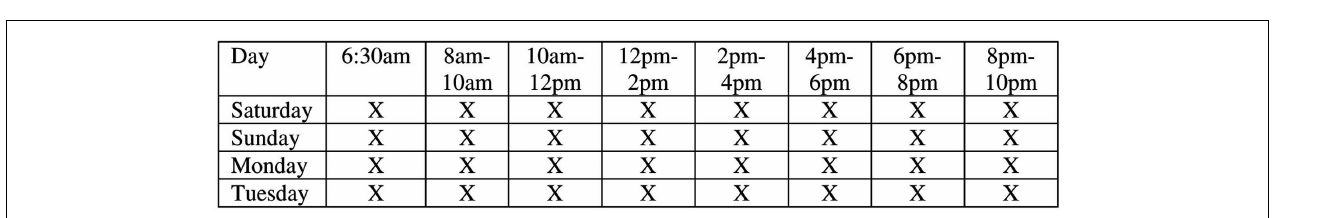
FIGURE 2 | Ecological momentary assessment (EMA) procedure. Each X represents an EMA survey that was prompted at a random time with the specified time